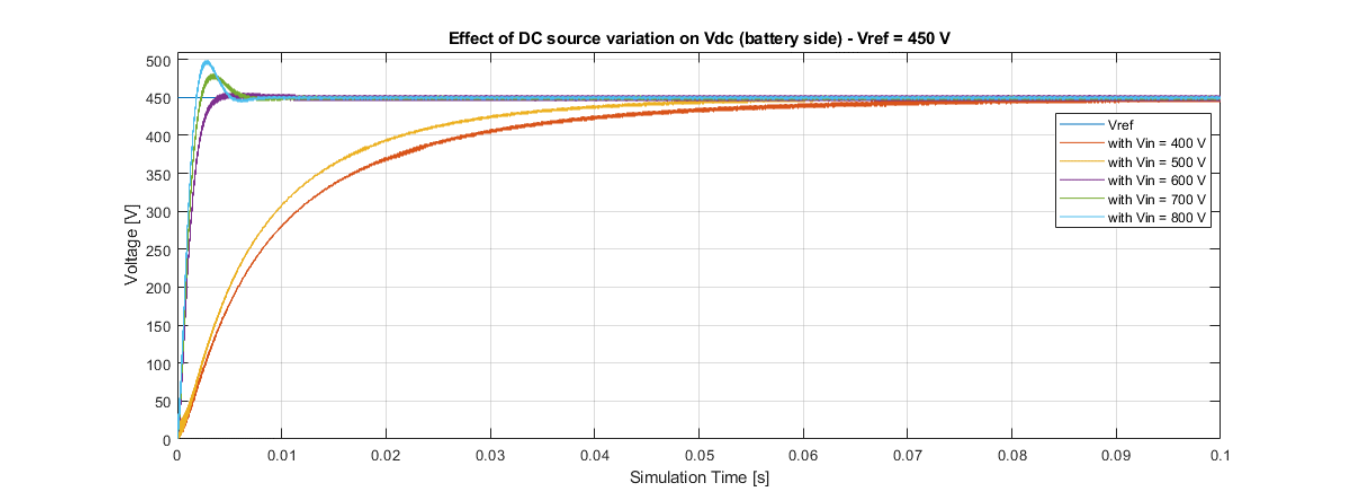
Figure 23. Effect of the V in variation on the output voltage control in the DAB converter, with V ref = 350 V.